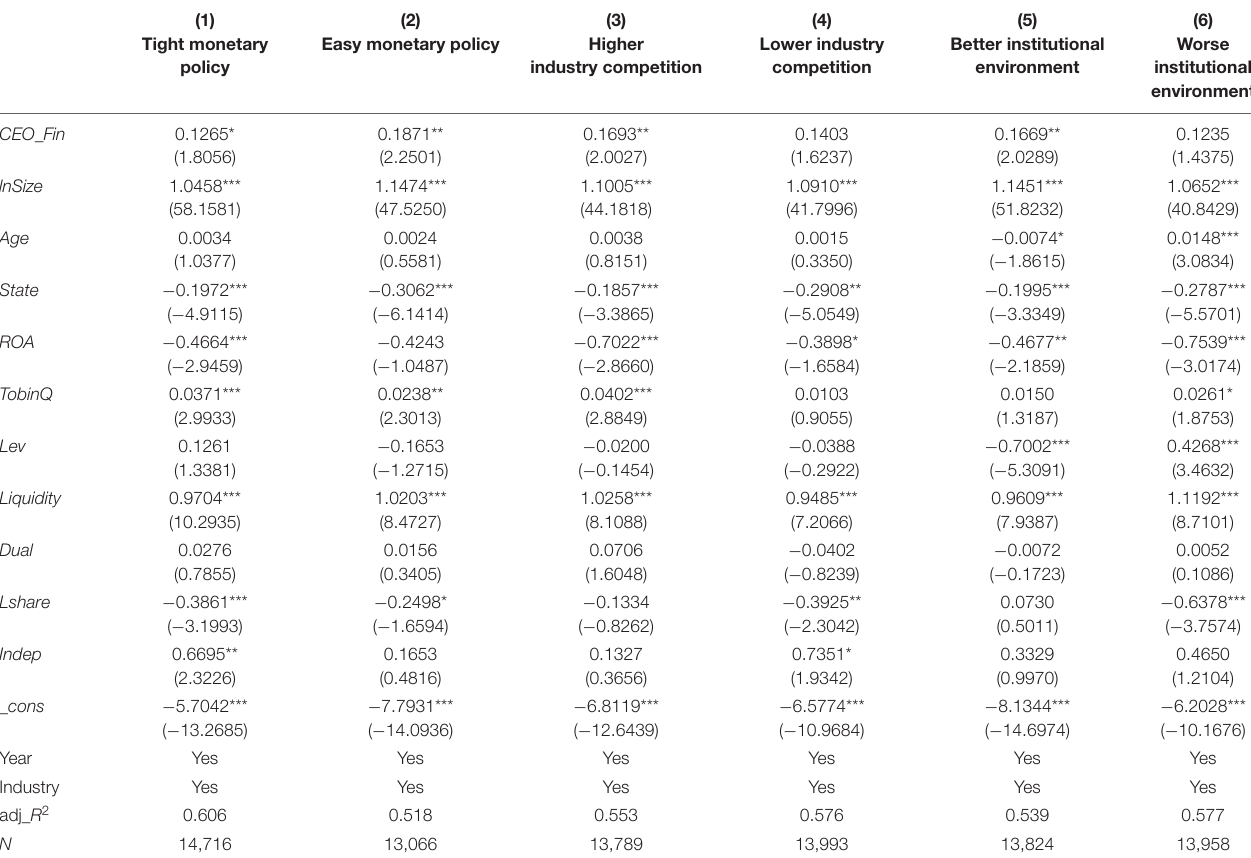
TABLE 9 | CEOs’ FB and shadow banking business of non-financial enterprises: external macro characteristics of